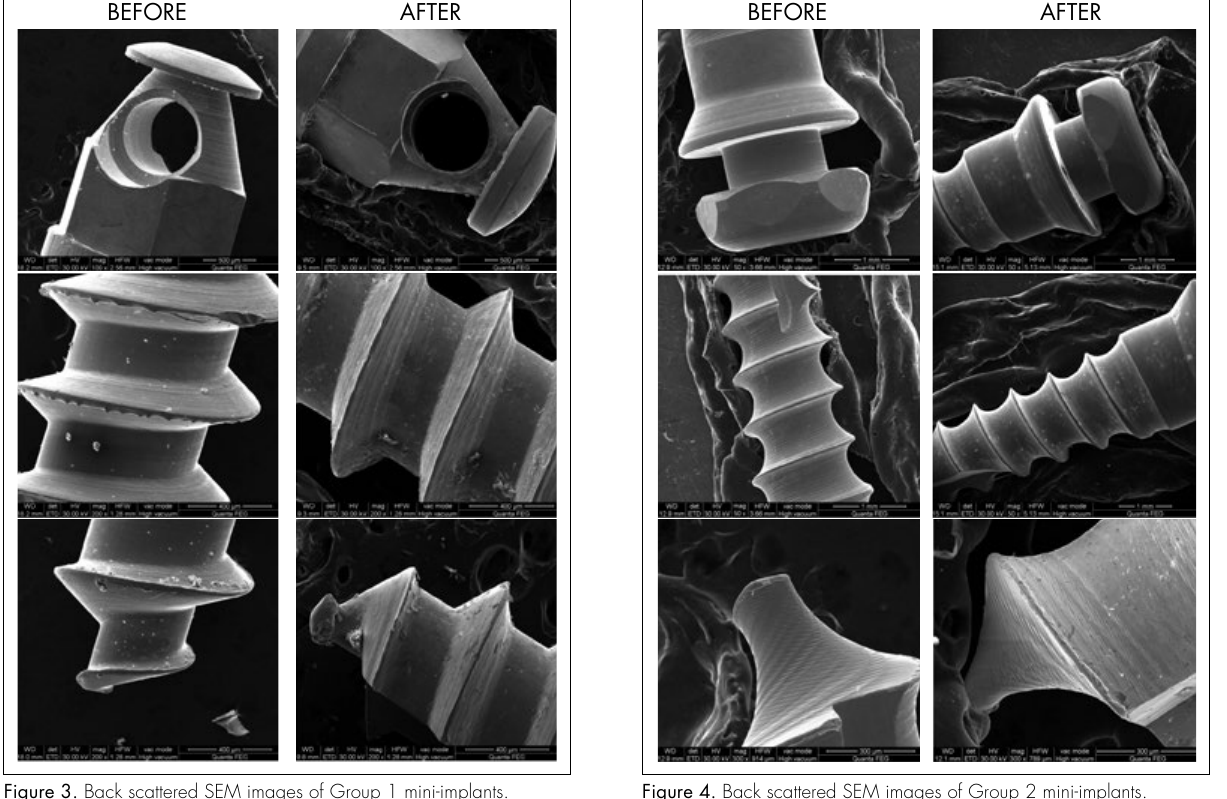
Figure 3. Back scattered SEM images of Group 1 mini-implants.